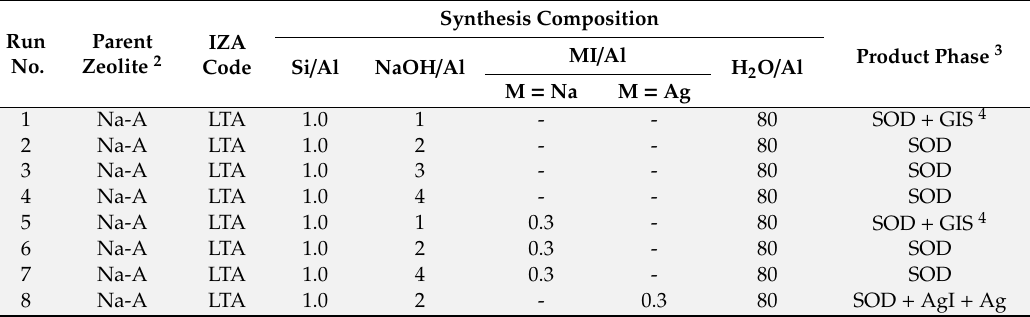
Table 1. Representative interconversion hydrothermal synthesis conditions and